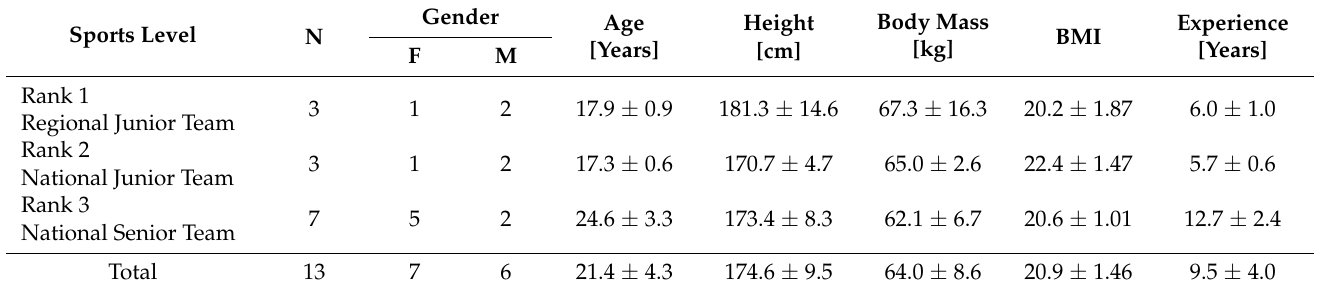
Table 1. Mean values and standard deviations of age, height, body mass, BMI, and sports experience in different sports level participants according to rank category.